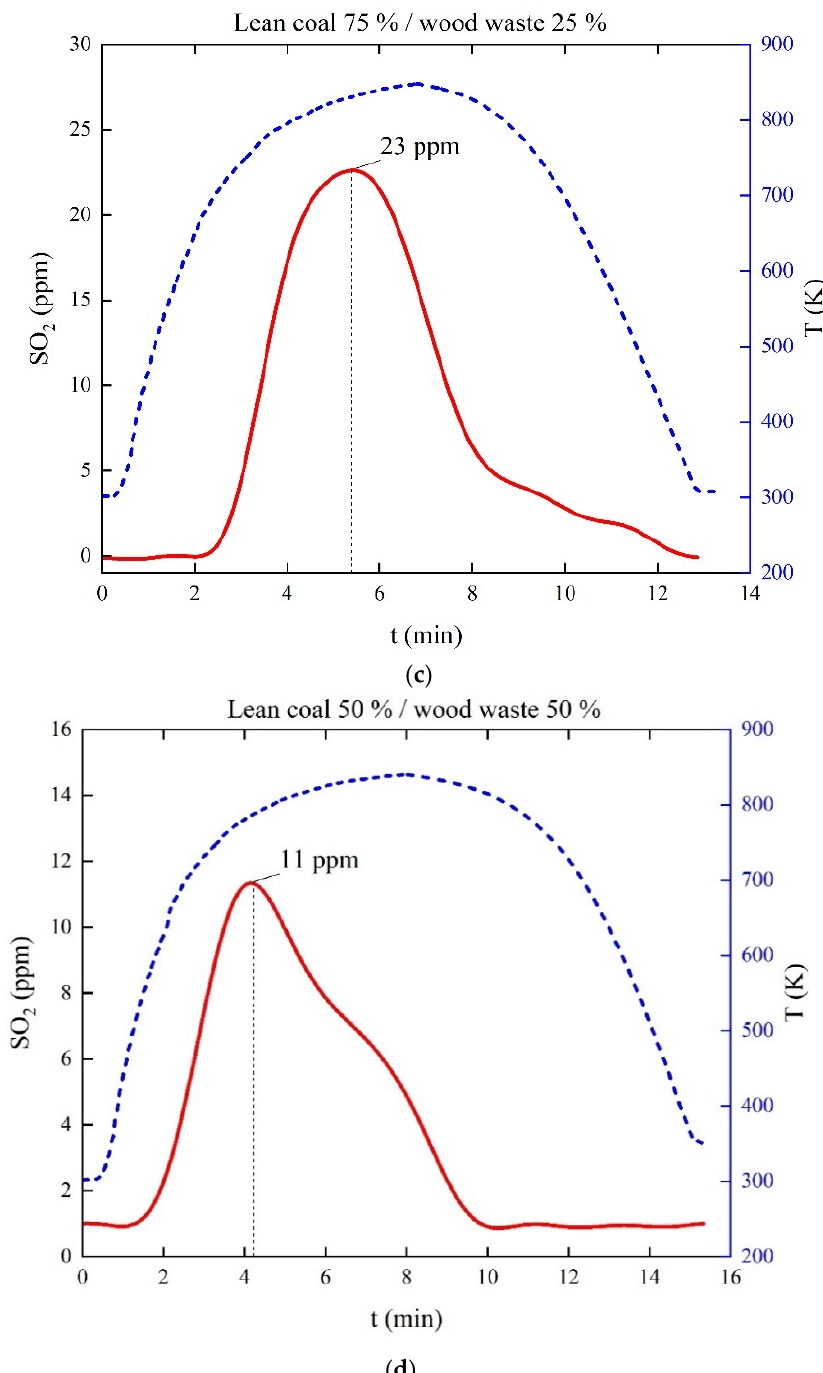
Figure 6. Changes in the concentration of sulfur oxides in the gaseous products of thermal decomposition of mixed fuels based on T-grade coal and wood with a change in the proportion of the latter in the mixture from 10% to 50%: ( a ) lean coal 100%; ( b ) lean coal 90%/wood waste 10%; ( c ) lean coal 75%/wood waste 25%; ( d ) lean coal 50%/wood waste 50%.